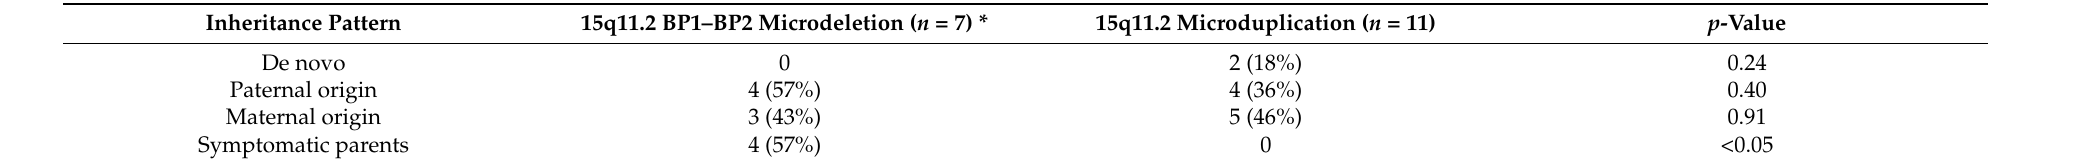
Table 4. Inheritance pattern and ratio of the symptomatic parents of the 15q11.2 BP1–BP2 microdeletion and microduplication groups.